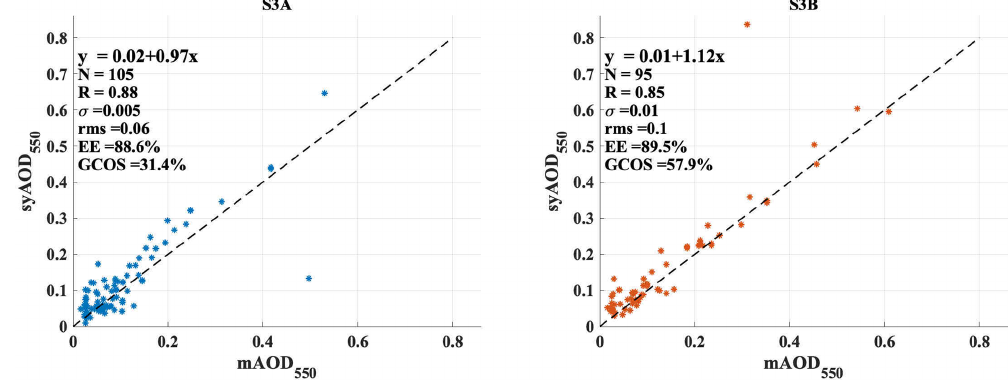
Figure 26. Scatter plots between S3A and S3B syAOD as well as MAN AOD (mAOD) with validation statistics.